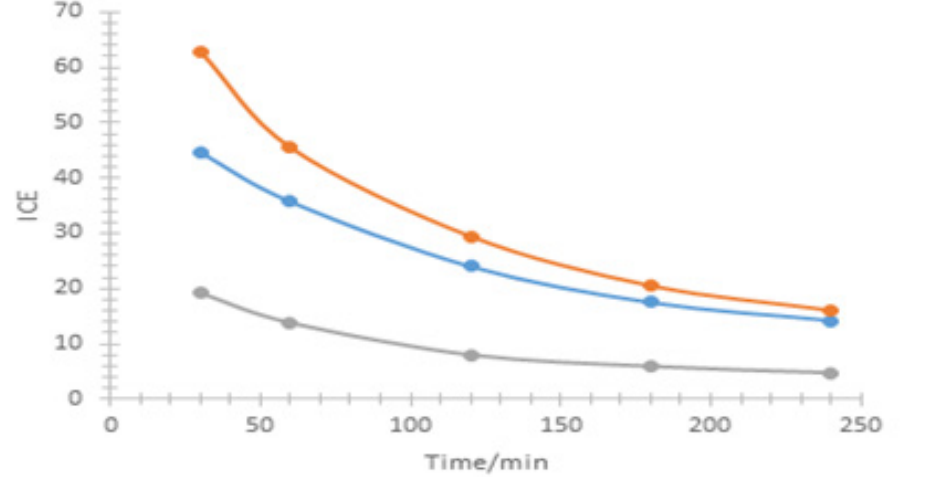
Figure 3: Instantaneous current efficiency change along the electro-Fenton process at different current intensities 60 ( ), 100 ( ), 300 (